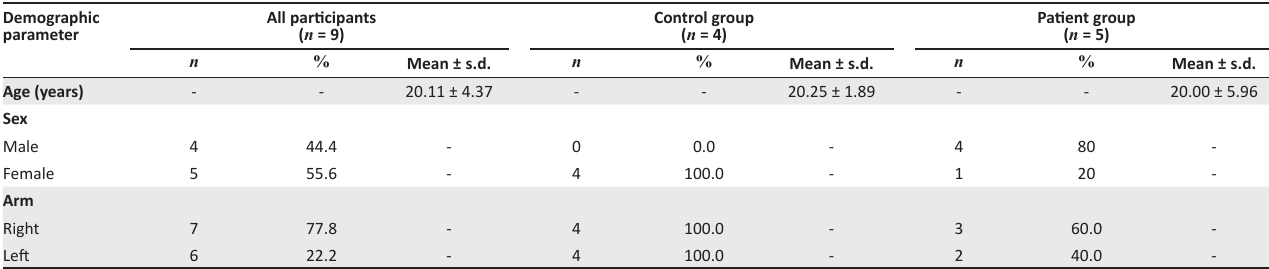
TABLE 2: Demographic profile of participants by age, sex and arm(s) involved. Demographic